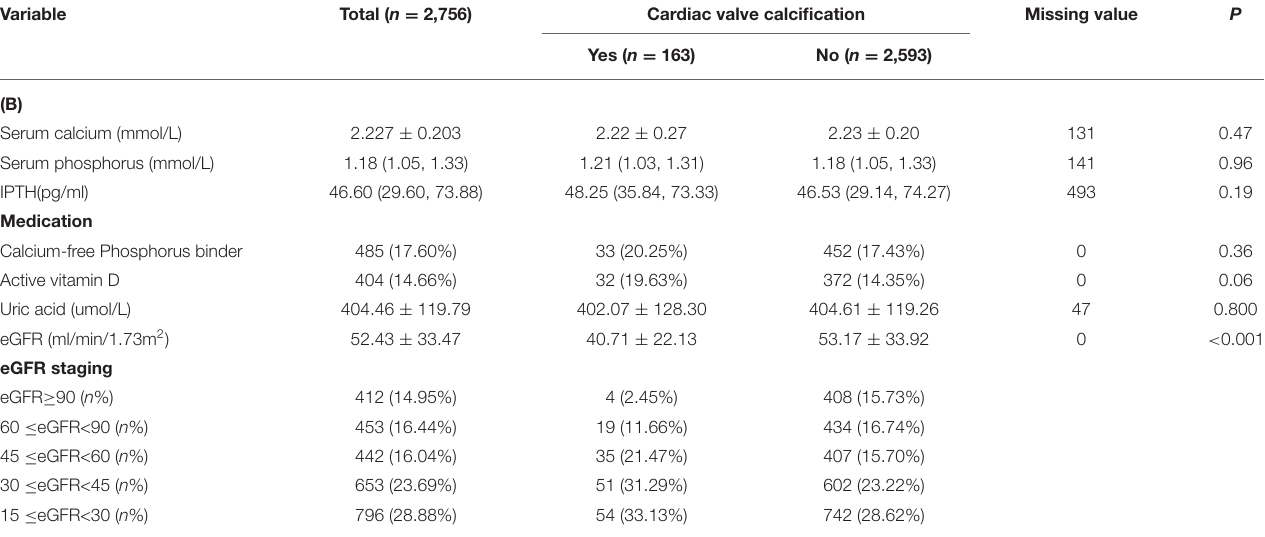
eGFR were also different with and without CVC. In addition, significant differences were noted in cholesterol and LDL-C between patients with and without CVC ( P = 0.028; P =